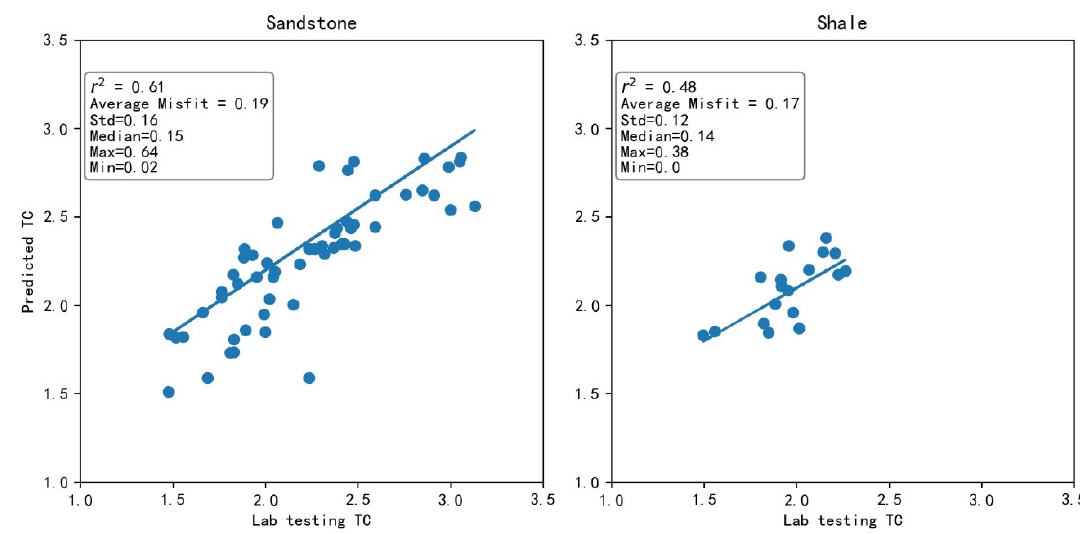
Figure 4. Relationship between the measured TC values and the predicted TC values.